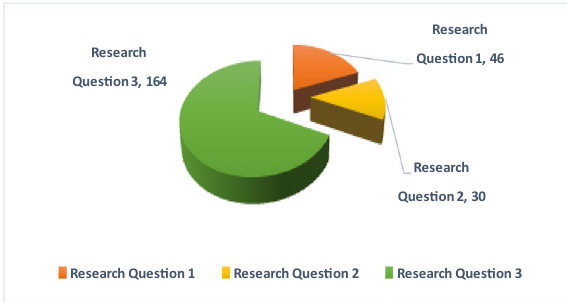
Fig. 10 The distribution of researches according to the three questions in last ten years